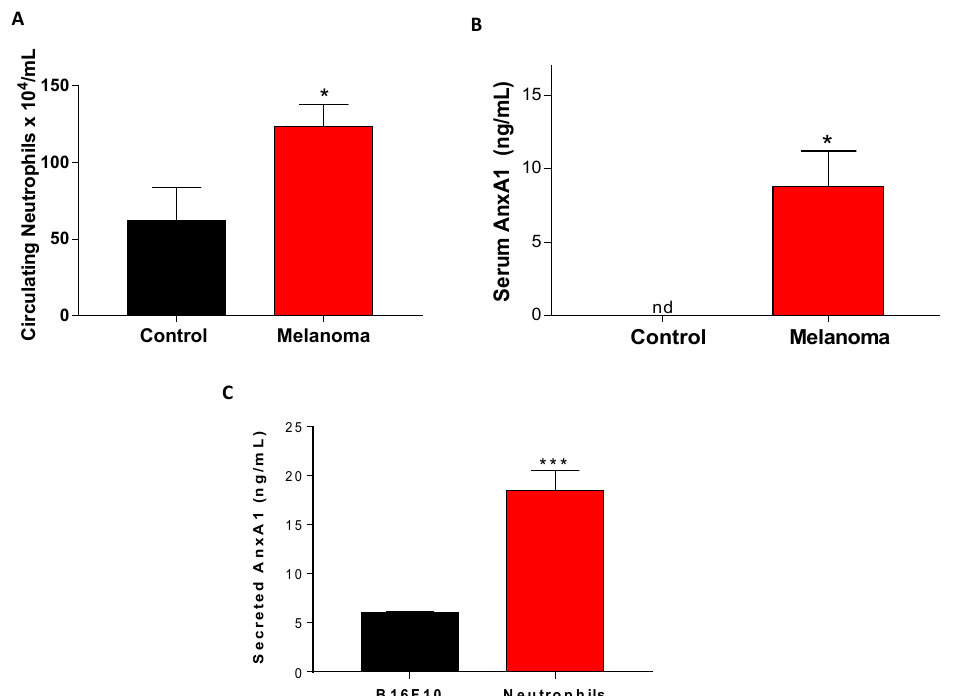
Figure 3. Increased blood neutrophils and AnxA1 levels in the lung melanoma metastasis model. ( A ) Amounts of neutrophils in the peripheral blood from lung melanoma metastasis mice. ( B ) Serum levels of AnxA1. ( C ) Secretion of AnxA1 by melanoma cells (B16F10) and neutrophils cultured for 24 h. The data represent the average ± SEM. * p < 0.05 vs. control; *** p < 0.001 vs. B16F10. Control group ( n = 5); melanoma group ( n =